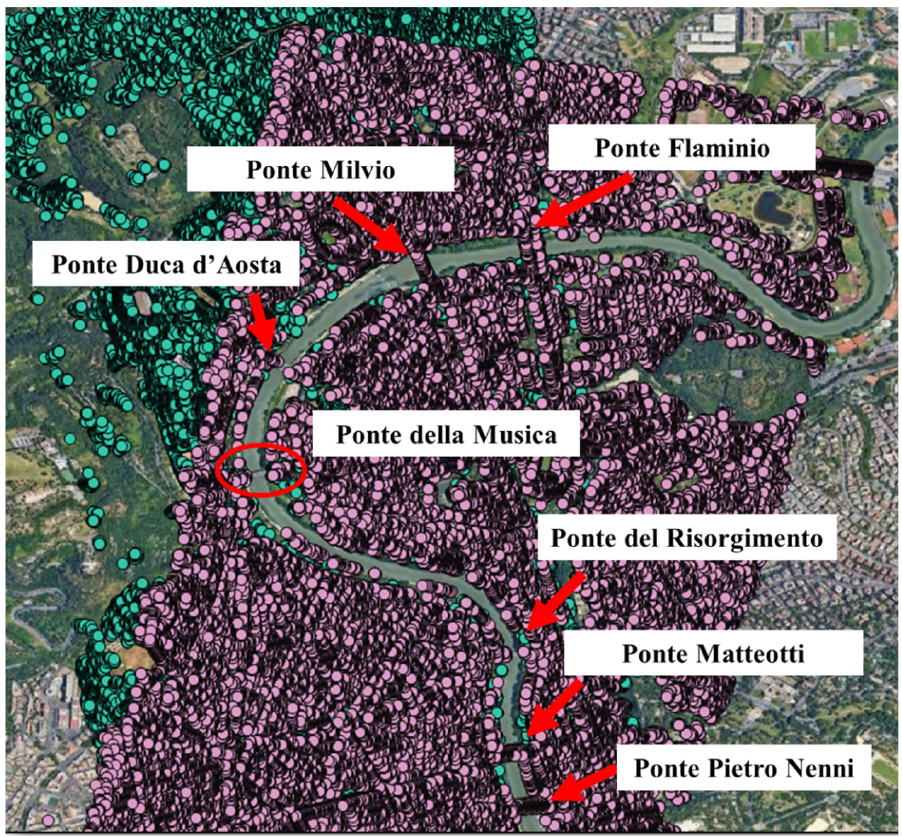
Figure 14. Distribution of the coherent pixels detected by the SBAS approach over the study area: ascending orbits in green and descending orbits in pink. Figures 15 and 16 show that bridges with high stiffness and with the piles in the riverbed (Ponte Matteotti, Ponte Pietro Nenni, Ponte Flaminio and Ponte Milvio) are almost covered by the satellite measurement points. By contrast, at Ponte Risorgimento and Ponte Duca d’Aosta the points detected by the satellite are not located on the deck, similar to the case of Ponte della